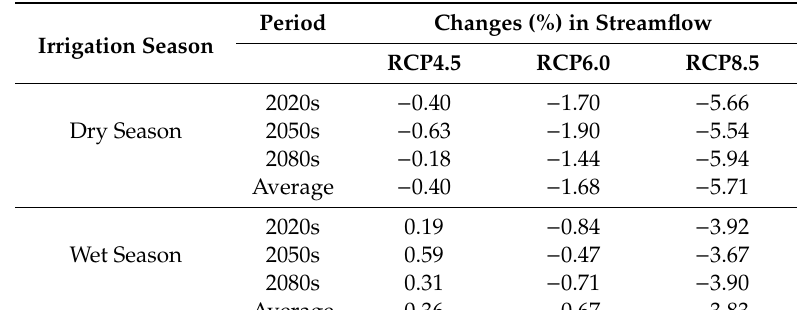
Table 4. Projected changes in streamflow under multi-model projections based on RCP scenarios relative to the baseline period of 1976–2005.